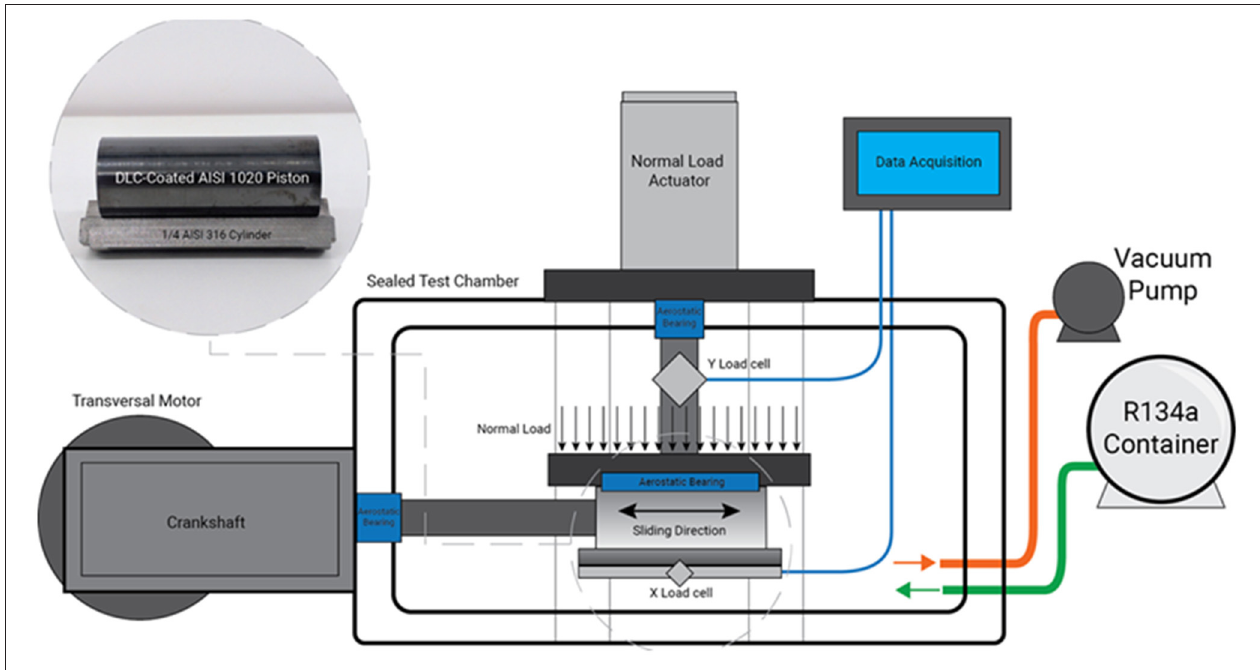
FIGURE 7 | Testing system overview. Tribopair zoomed in.